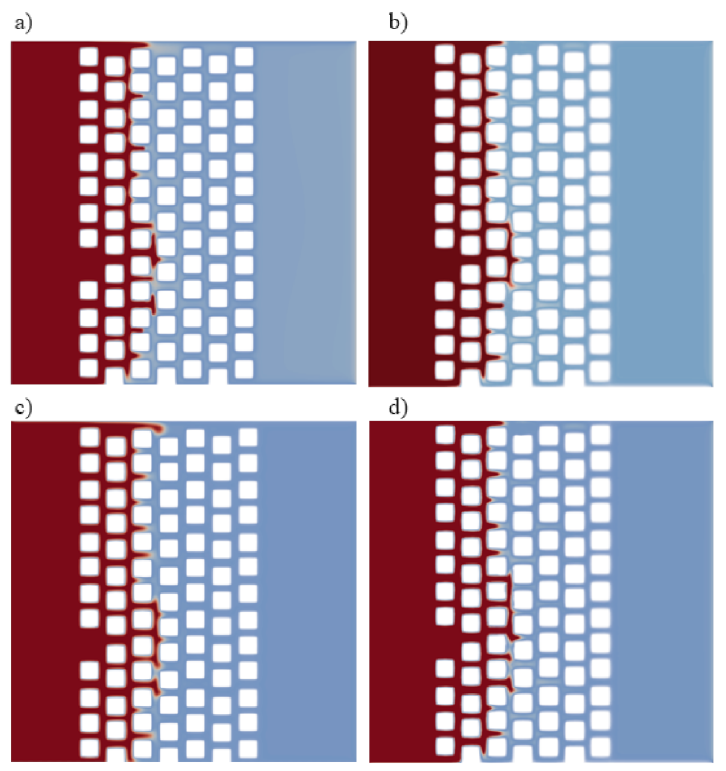
Figure 12. Gaseous phase penetration for square pores at t ∗ = 0.225 time-step with fixed C a = 0.038,